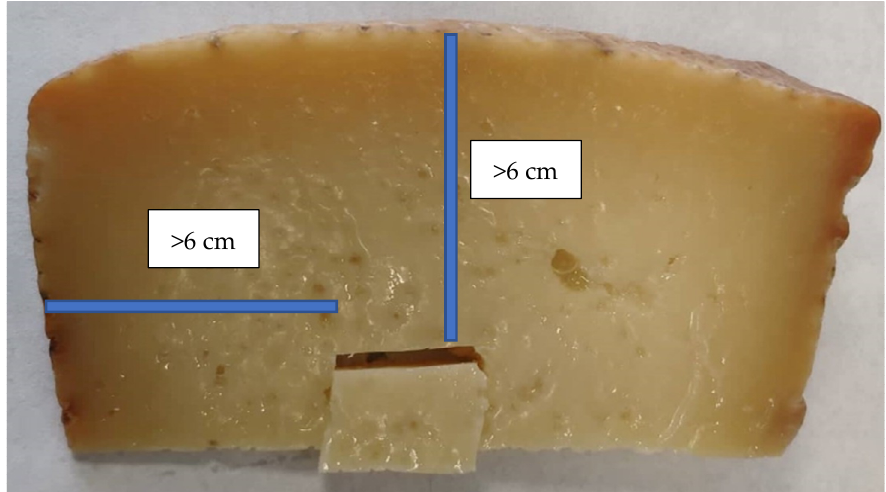
Figure 2. Cheese sample taken at core during the ALP analysis.